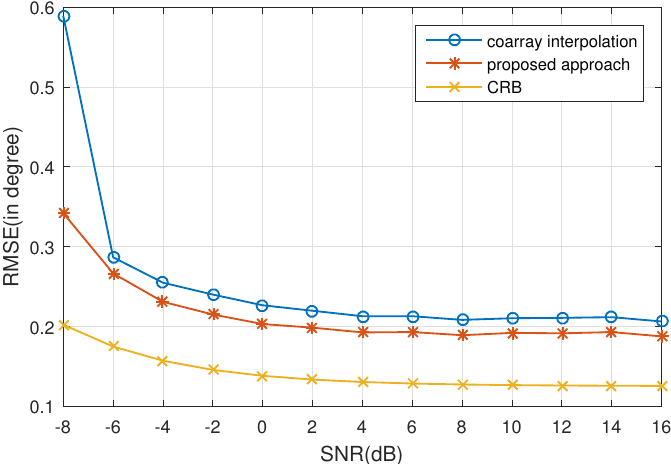
Figure 3. Root mean square error (RMSE) vs. SNR for 500 Monte Carlo experiments with Q = 16 sources uniformly distributed in [ − 50 ◦ ,50 ◦ ] . The number of snapshots is K = 500. CRB: Cramér–Rao Bound.